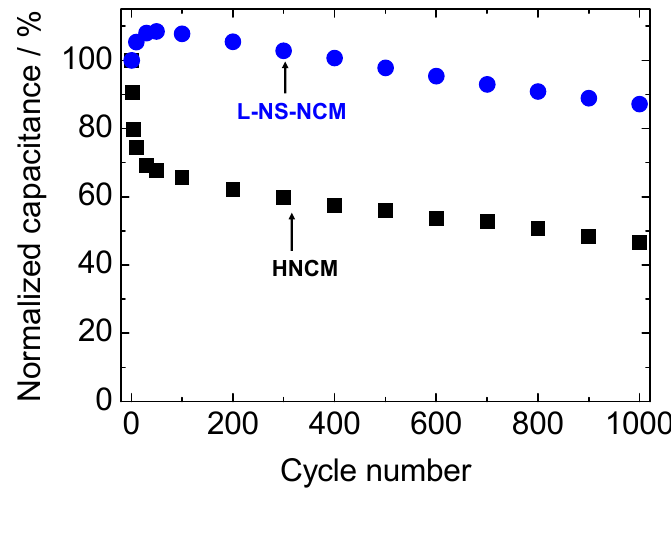
Figure 8. Normalized cycle stabilities of HNCM and L-NS-NCM at a current density